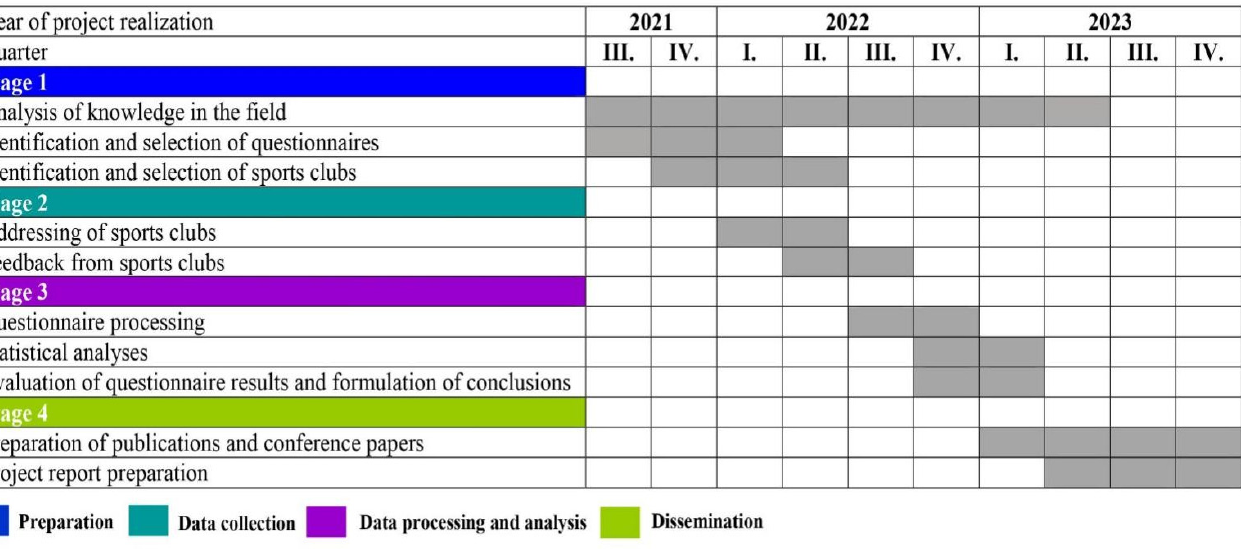
Figure 1. Timeline of study protocol.